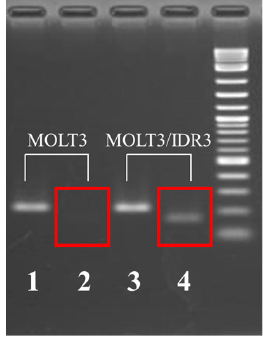
Figure 2. Identification of wild-type and mutant GALNT2 in MOLT-3 and MOLT-3/IDR cells by